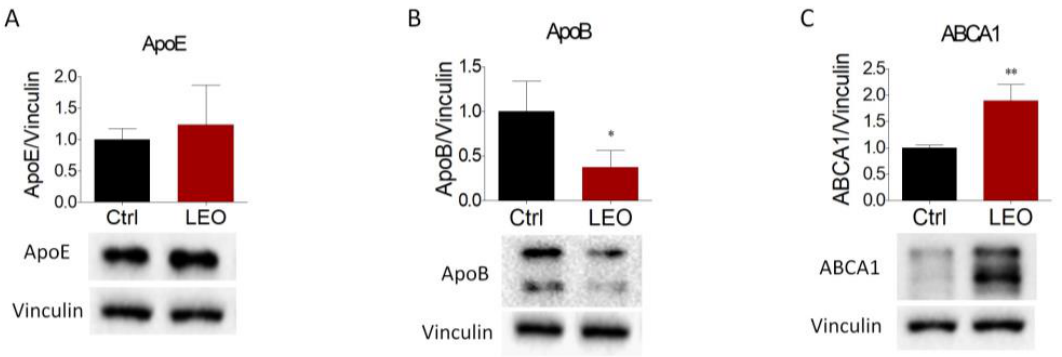
Figure 4. Effects of LEO on the expression of proteins involved in cholesterol transport in HepG2 cells. ( A – C ) After stimulation with LEO (0.005%) and the vehicle (DMSO, Ctrl cells) for 24 h, HepG2 cells were collected and subjected to Western blot analysis to evaluate apoE, apoB, and ABCA1 protein expression. Vinculin was chosen as the loading control. n = 3 independent experiments. Data represent means ± SD. Statistical analysis was performed using the unpaired Student’s t -test. * p < 0.05; ** p < 0.01.